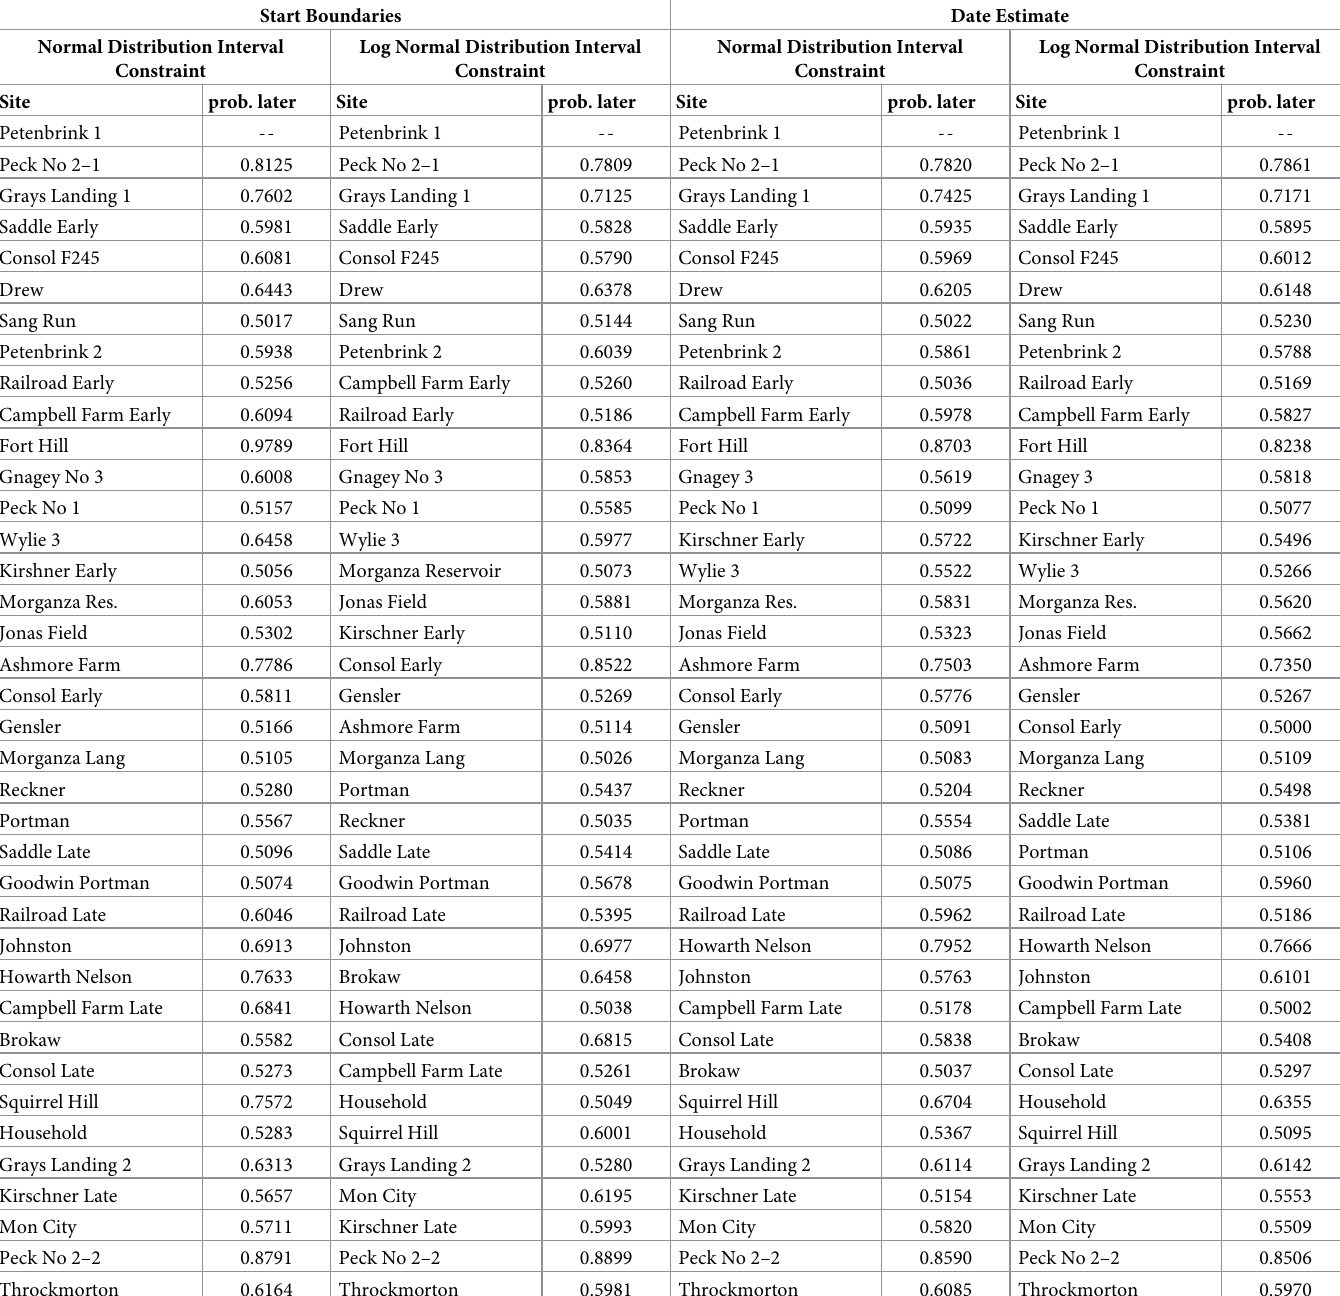
Table 5. Summary of site order probability matrices (see S2